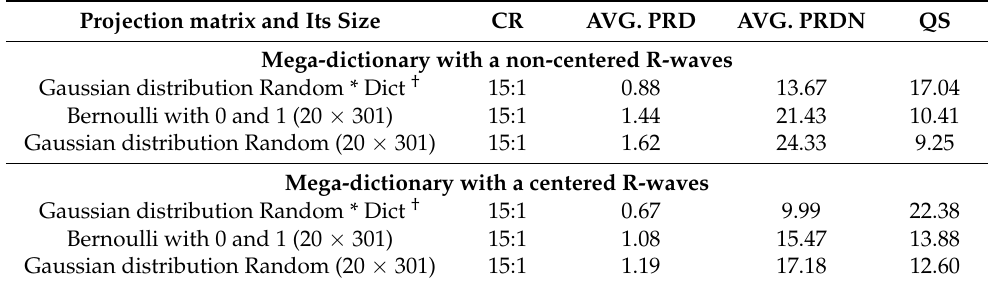
Table 4. Average results for 24 ECG records processed with the CSCP method with the mega